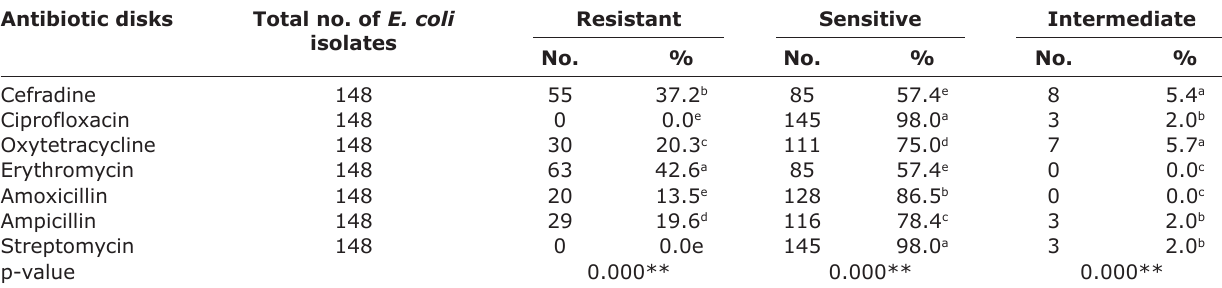
Table-9: Results of the antibiotic sensitivity test of E. coli isolated from milk and milk by-products. Antibiotic disks